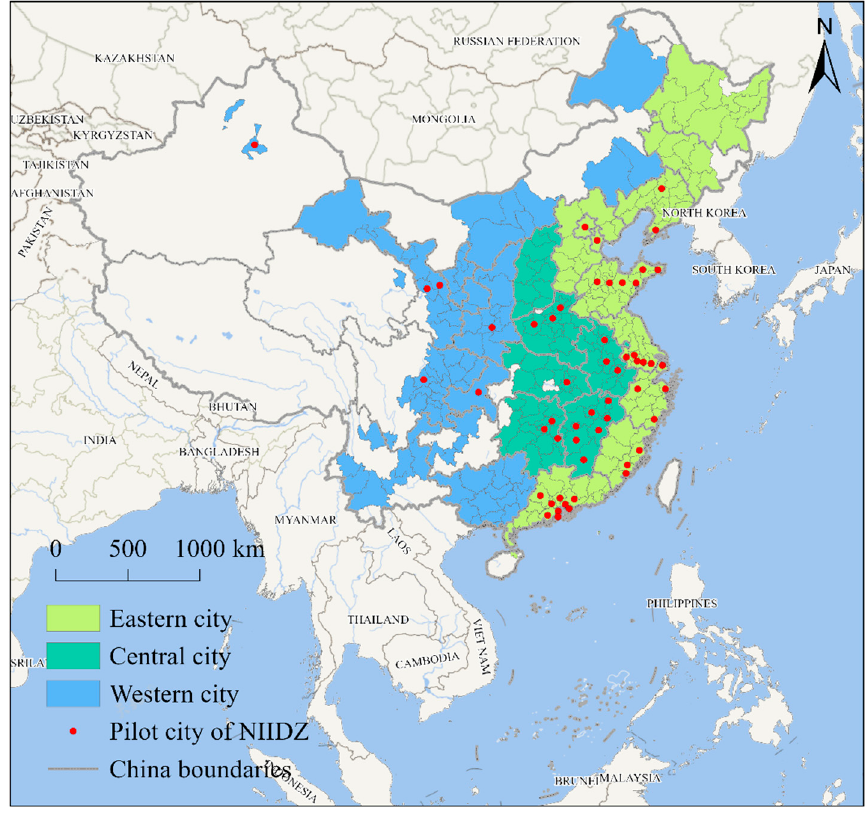
Figure 1. Samples of NIIDZ pilot cities in China.